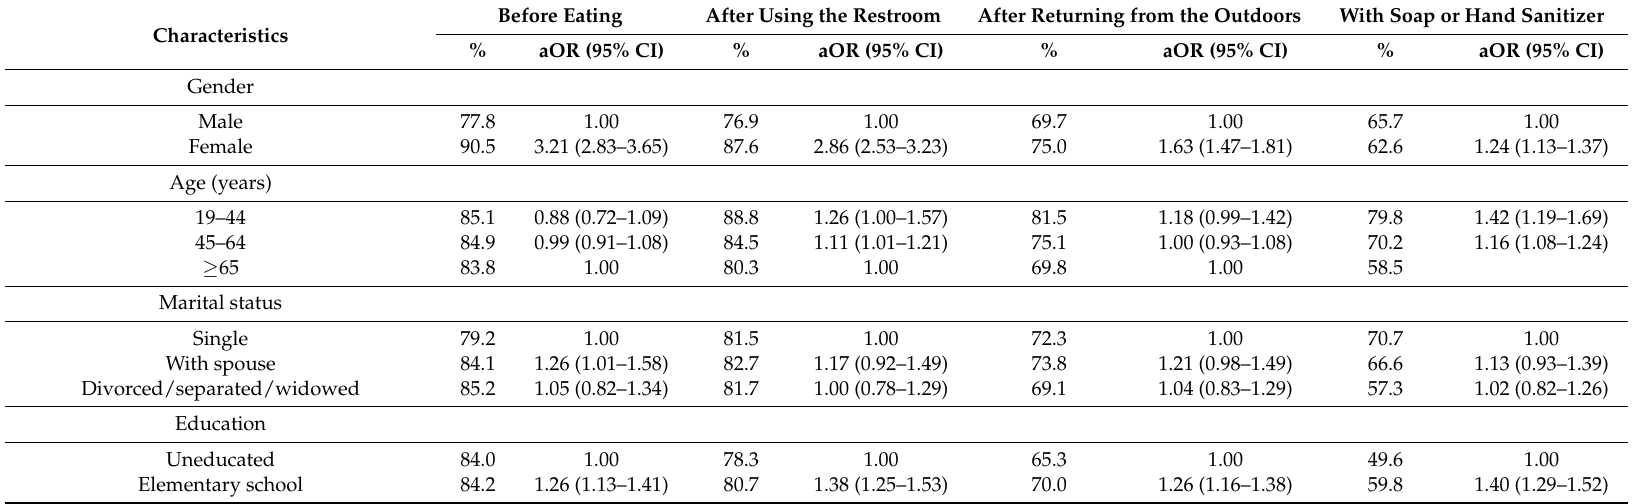
Table 3. Factors associated with frequent handwashing among people with